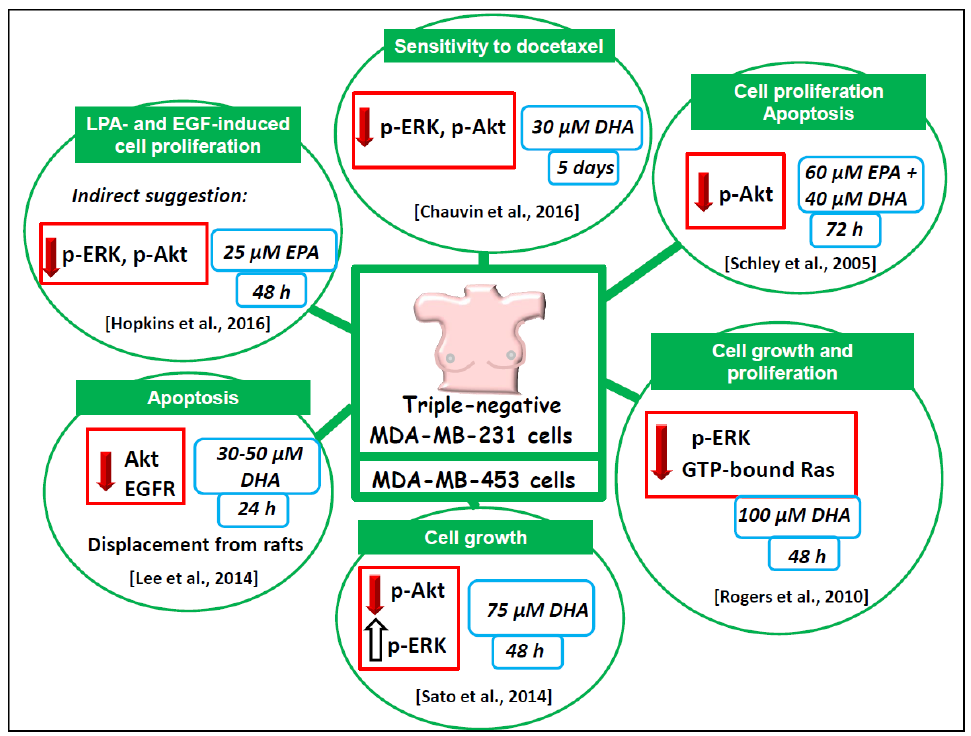
Figure 3. Outline of the main results of the in vitro reports investigating LCn-3 PUFA regulation of ERK, AKT and their upstream components in the ERK and phosphoinositide survival pathways in triple negative breast cancer cells. The green labels show the main features, functions, or cellular processes that are related to cell growth and regulated in an antineoplastic manner by LCn-3 PUFA in MDA-MB-231 and MDA-MB-453 breast cancer cells. The red arrows indicate a negative regulation by LCn-3 PUFA, and the empty arrow indicates activation. The blue boxes illustrate the LCn-3 PUFA concentrations used and the duration of incubation with fatty acids.